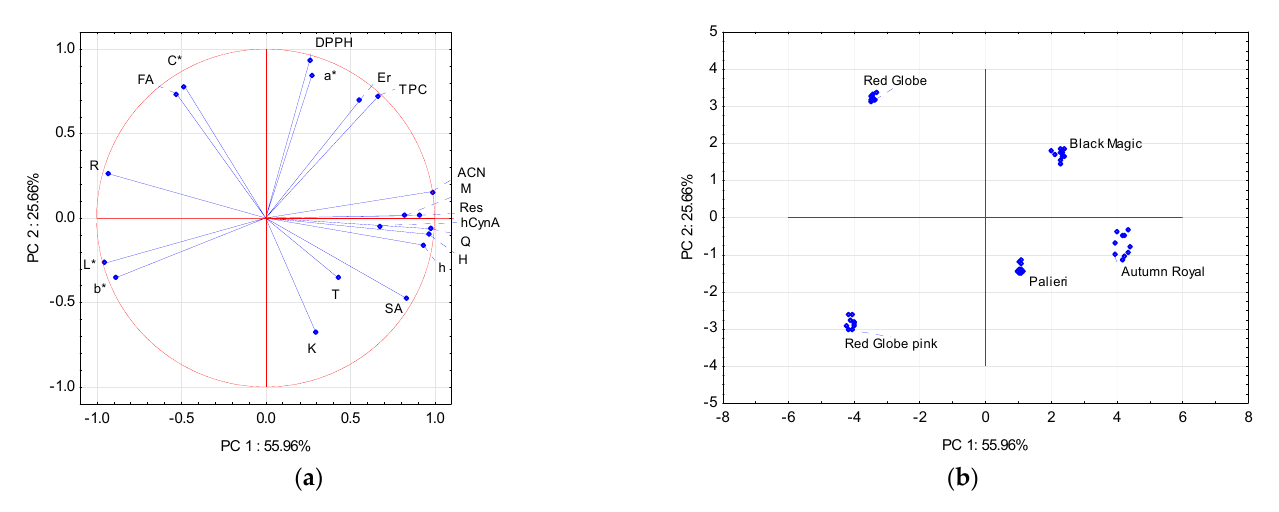
Figure 1. Projections of the variables ( a ) and scores ( b ) onto the factor plane defined by principal components (PC1 and PC2). Note: SA—sinapic acid; FA—ferulic acid; hCynA—hydroxycinnamic components (PC1 and PC2). Note: SA—sinapic acid; FA—ferulic acid;